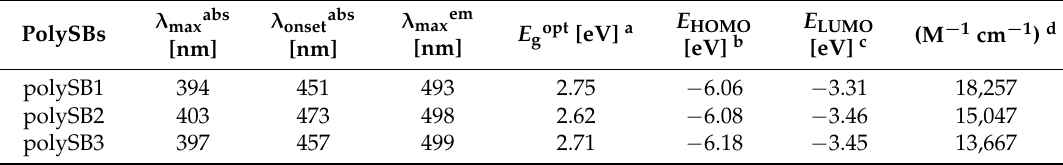
Table 2. Optical and electrochemical properties of polySBs.